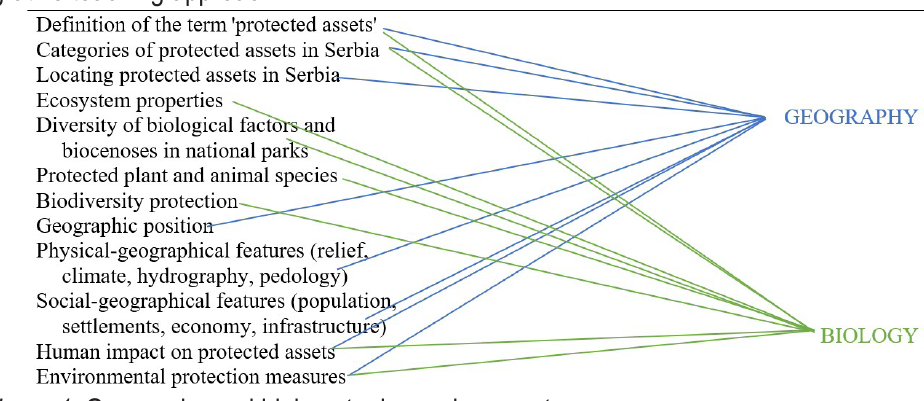
Figure 1. Geography and biology topics and concept